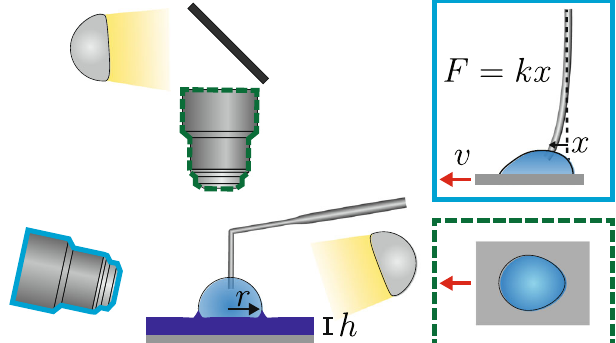
Fig.1|Experimentalapparatus. Schematic of the apparatus usedto measure the geometry and forces acting on droplets in motion. The fi lm thickness, h , and size of droplet (radius, r ) are set prior to commencing an experiment. The droplet is imaged simultaneously in two axes (schematic imagesfrom each axis included to the right).Thesubstrate istranslatedatspeed v toproducerelativemotionofthe droplet, which is held in place by a thin micropipette. Force measurement is obtained through the de fl ection of the micropipette as indicated in the side axis